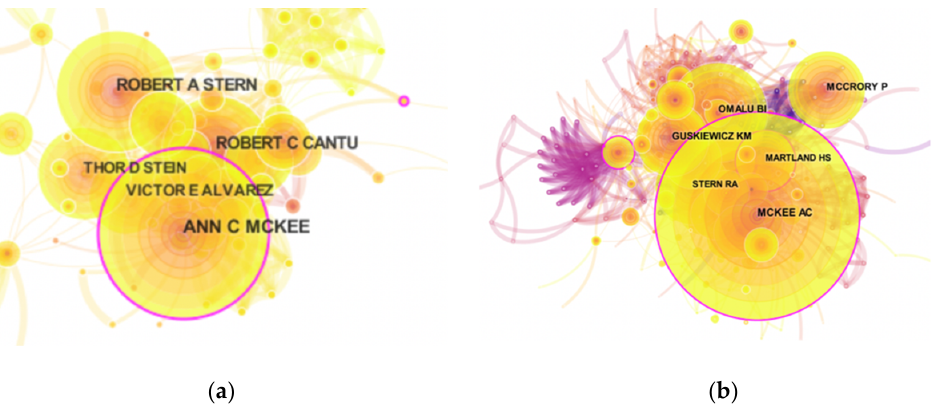
Figure 6. ( a ) Map of authors active in CTE research. ( b ) Map of co-cited authors active in CTE research. The nodes represent the authors, and the color depth and shape of the circles are positively correlated to the number of posts. The thickness of the connecting lines represents the strength of collaboration.